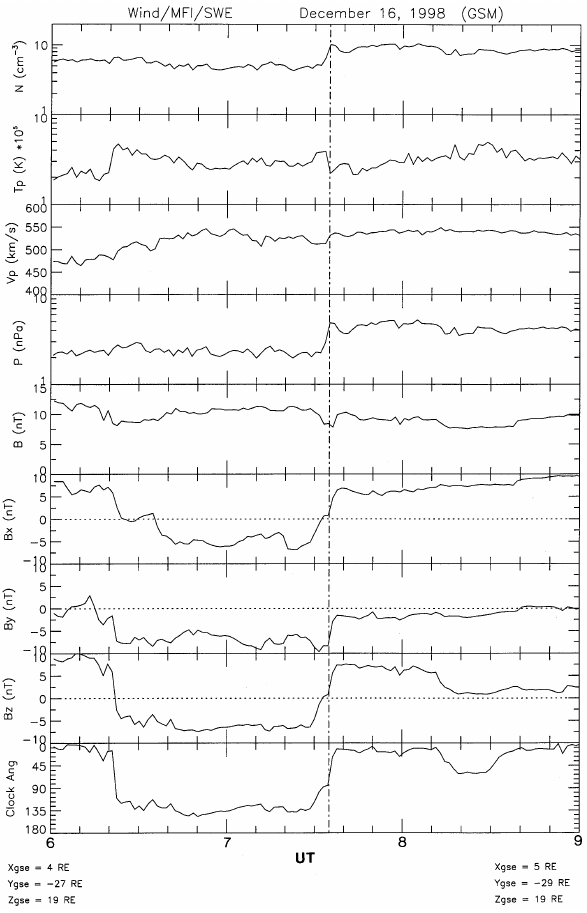
Fig. 1. Wind plasma and magnetic field observations from the Mag- netic Field Investigation and Solar Wind Experiment instruments. From top to bottom are shown the proton density, temperature, bulk speed, dynamic pressure, the total field, its GSM x, y , and z com- ponents, and the IMF clock angle. The IMF northward turning cen- tered at 0735 UT is marked by vertical dash-dot line.